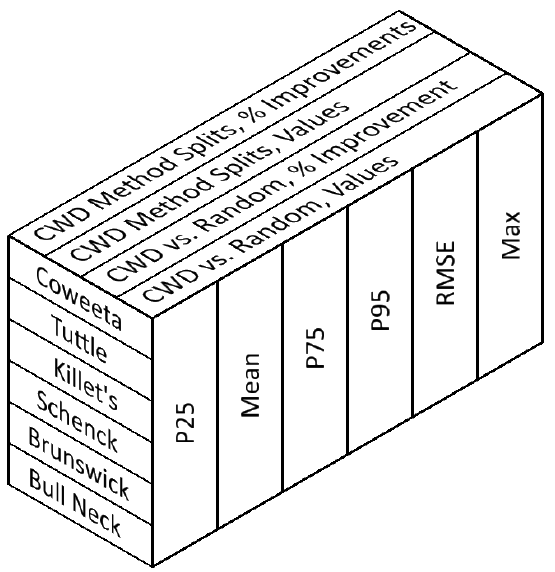
Figure 6. Matrix box showing axes of 144 chart permutations generated to analyze the introduced error assessment runs. The names, Coweeta, Tuttle, etc., are the short geographic names of the six Lidar panels used for the study and are described in Section Data (Study Panels).